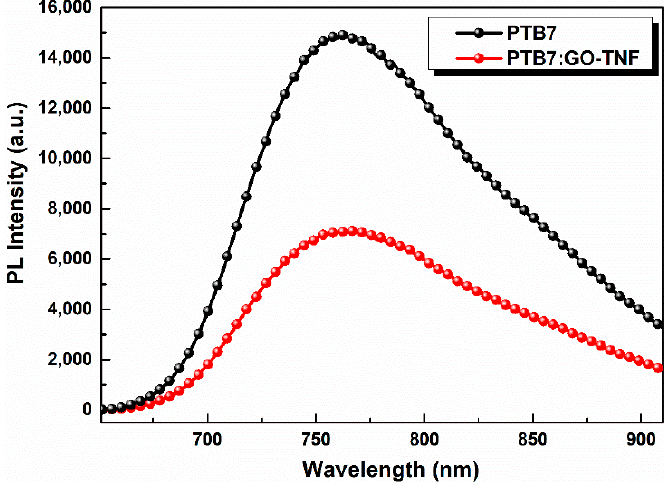
Figure 6. PL spectra of PTB7 (black) and PTB7:GO-TNF (2%) (red).